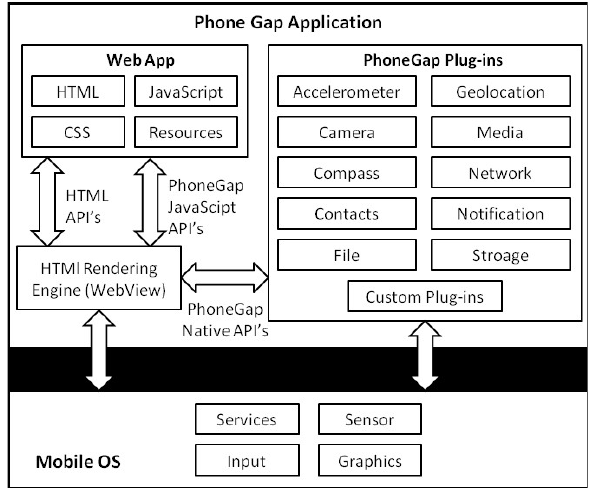
Figure 1 Phone Gap Application working principle